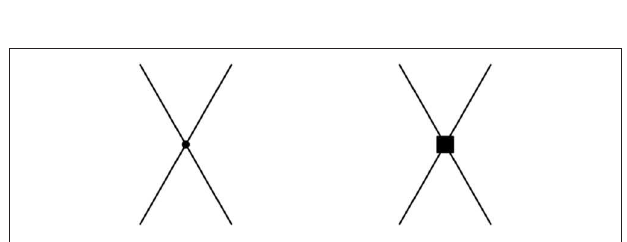
FIGURE 6 | Leading-order and next-to-leading-order baryon-baryon contact